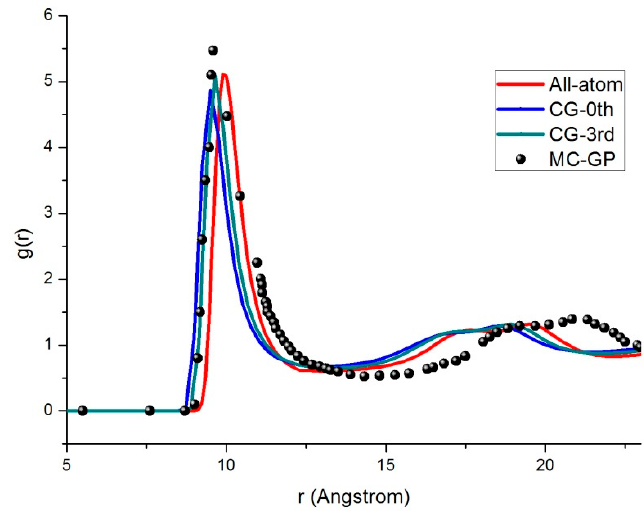
Figure 6. Radial distribution functions of the center of mass for different models representing fullerene molecules.